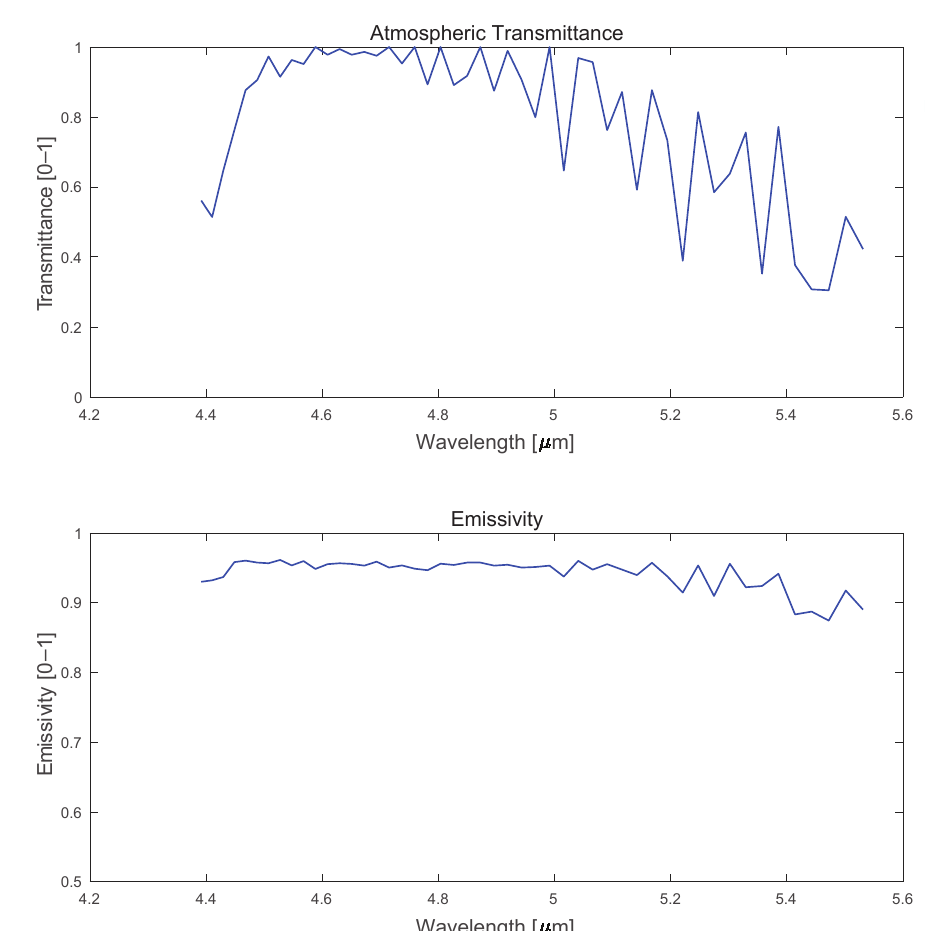
Figure 13. Top chart shows separated atmospheric transmittance, and bottom chart, separated emissivity of a sample